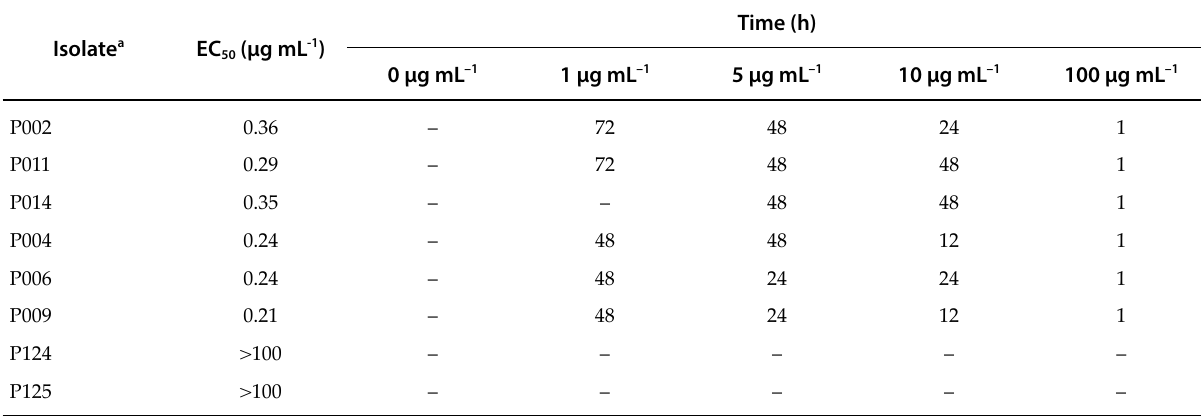
Table 2. Time required for inactivation of Pythium at different concentrations of mefenoxam. Isolate